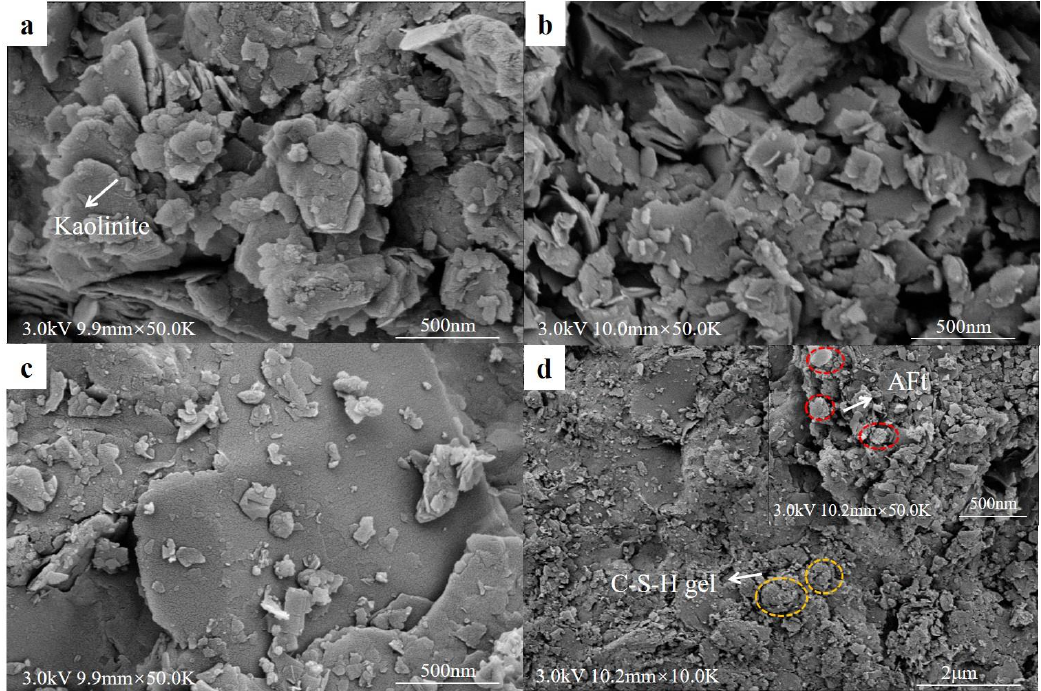
Figure 2. SEM images of different samples (( a ): RCG, ( b ): Ac-MCG, ( c ): Ne-LCG, and ( d ): Al-CG).